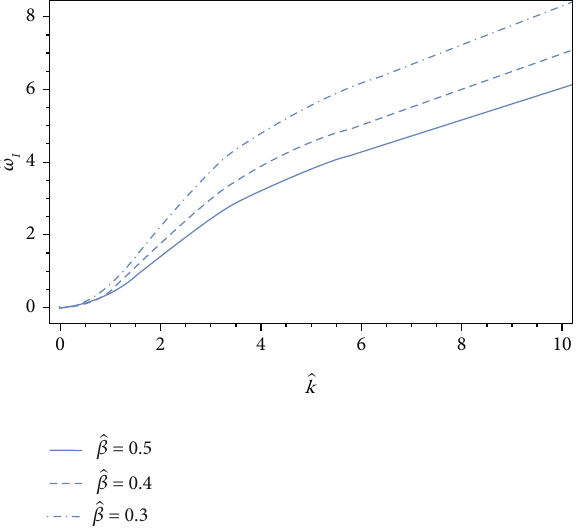
Figure 7: E ff ect of heat and mass transfer parameter b β on growth rate curves at b ρ = 0 : 002 , b μ ′ = 0 : 6 , b μ = 0 : 4 , L = 0 : 3 , Oh = 100 , b ε m = 0 : 3 , Ce = 3 , Ce = 6 , and ̂ H = 20 . 2 1